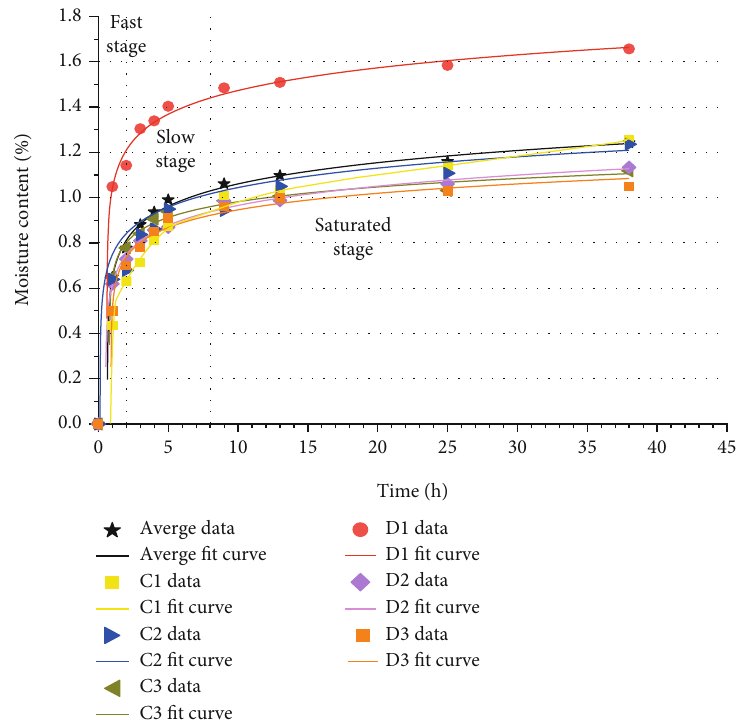
Figure 2: Relationship between time and moisture content of deep coal sample.